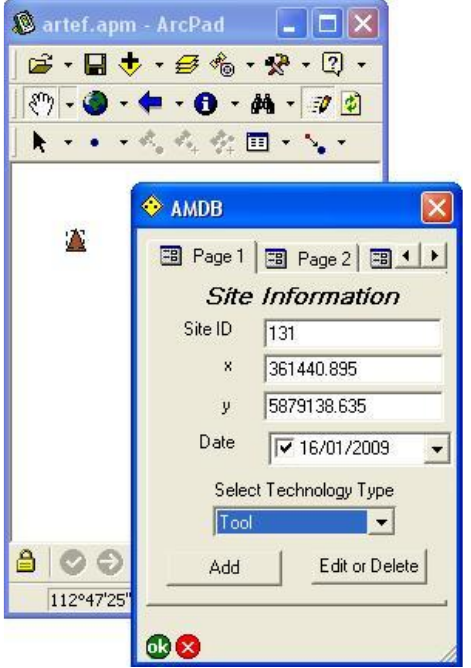
Figure 3 Customised form depicting the location of the test pit